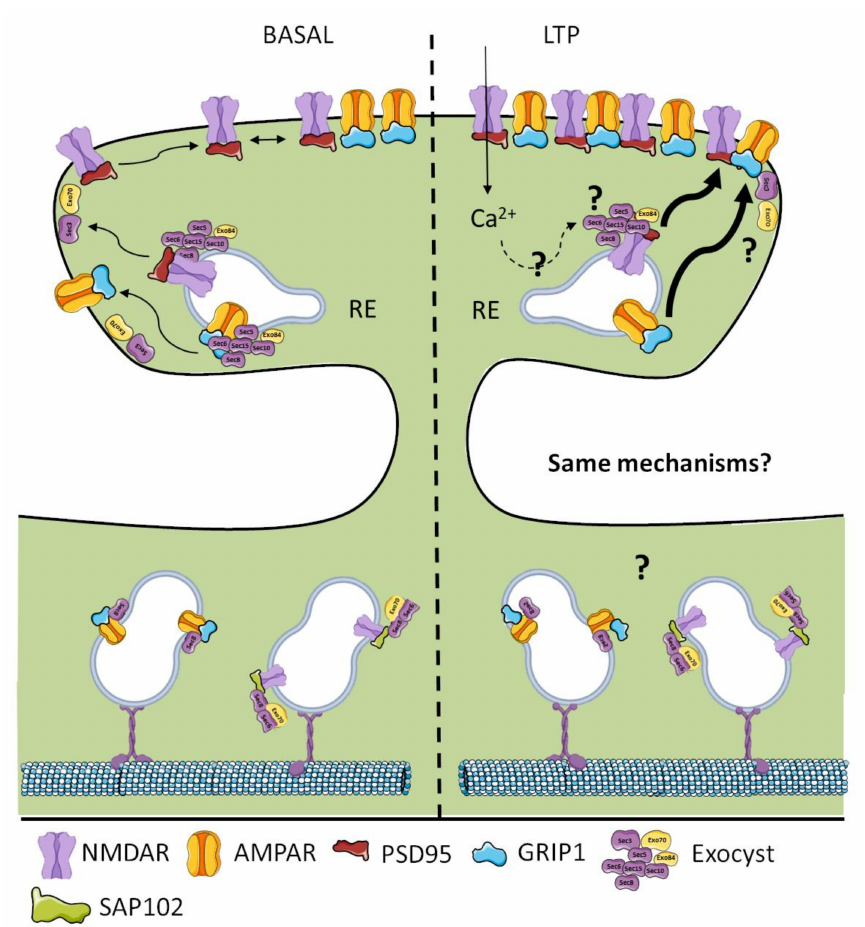
Figure 4. Exocyst in glutamatergic receptors tra ffi cking. (Left) In basal conditions, AMPARs